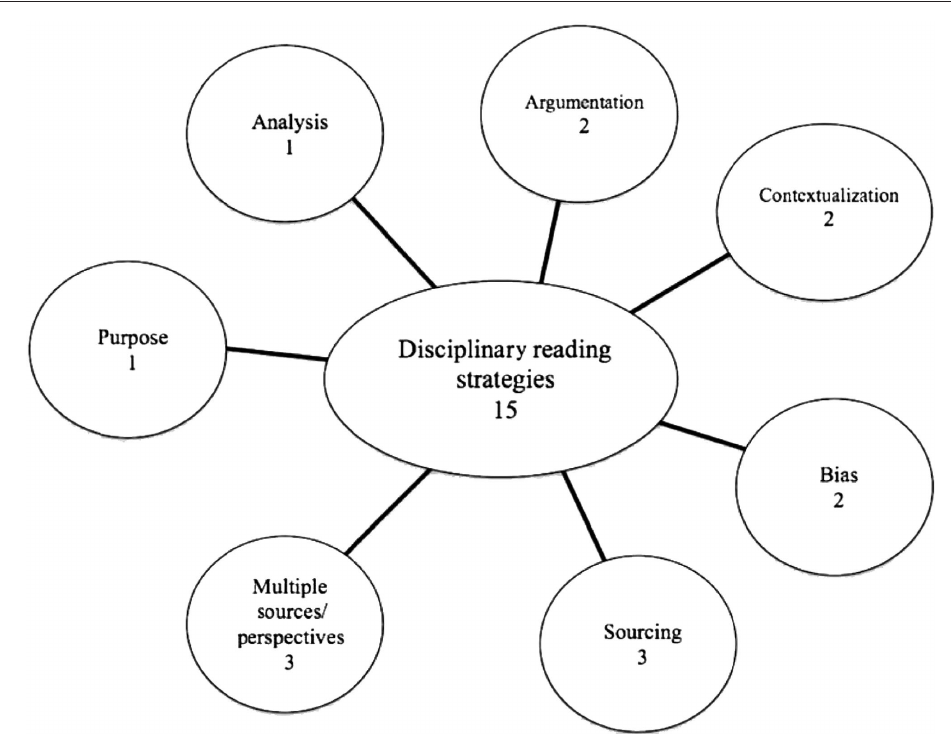
Figure 2: Disciplinary reading strategies that teachers identified teaching